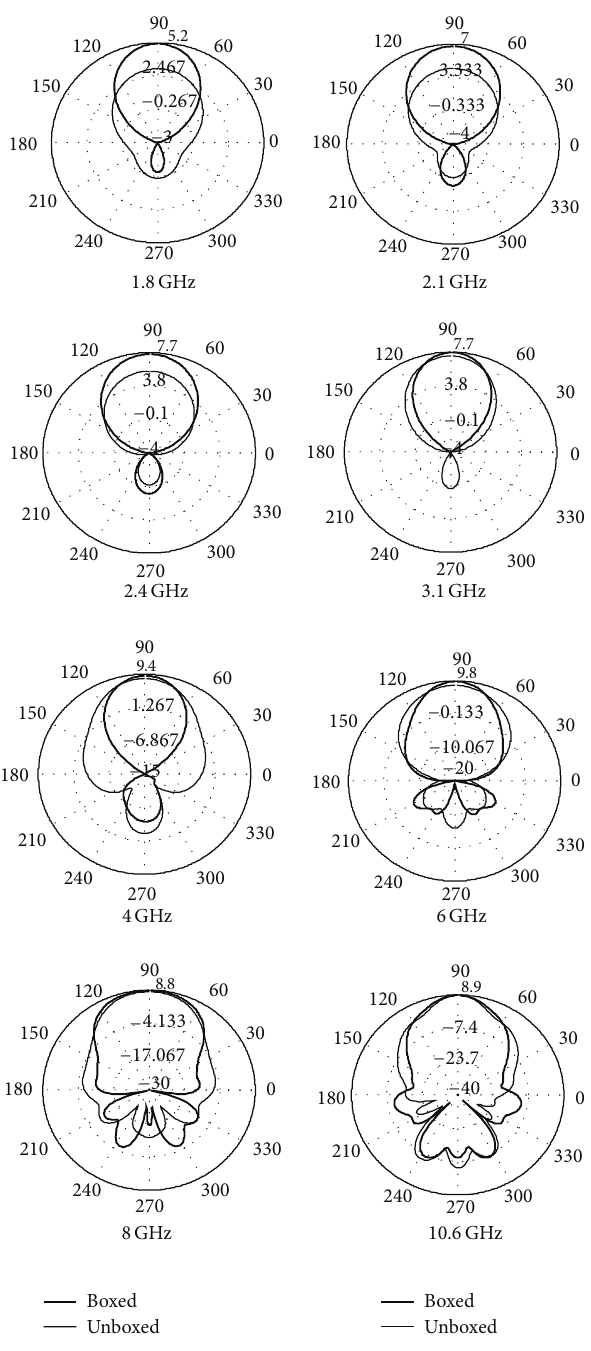
Figure 4: The simulated radiation patterns of the VS-PDL TEM horn antenna for “boxed” and “unboxed” configurations at various frequencies.